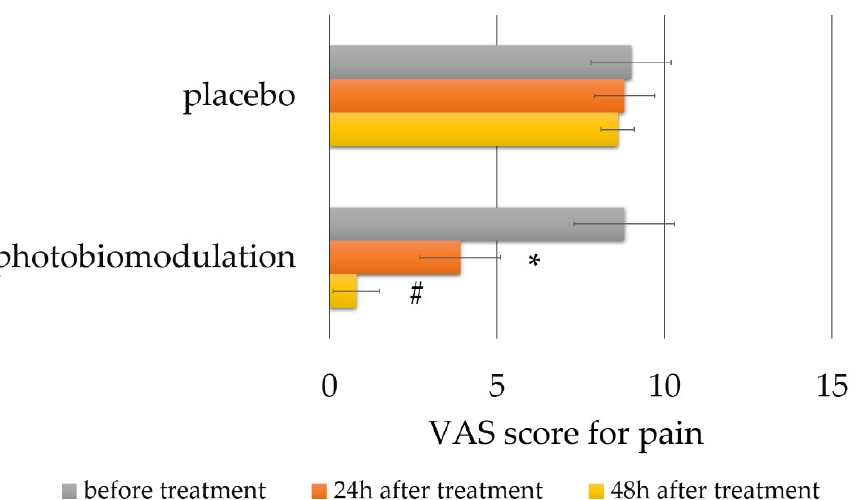
Figure 6. Effect of photobiomodulation and placebo treatment on pain. Photobiomodulation therapy induced a statistically significant reduction of the pain 24 and 48 h after photobiomodulation treatment. * p < 0.05 = before treatment vs. 24 h after treatment; # p < 0.05 = 24 h after treatment vs. 48 h after treatment. VAS = Visual Analogue Scale.